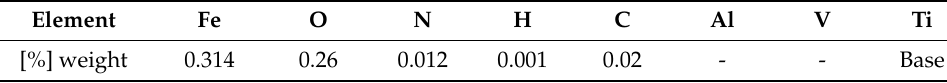
Table 1. Chemical composition of investigated titanium Grade4.